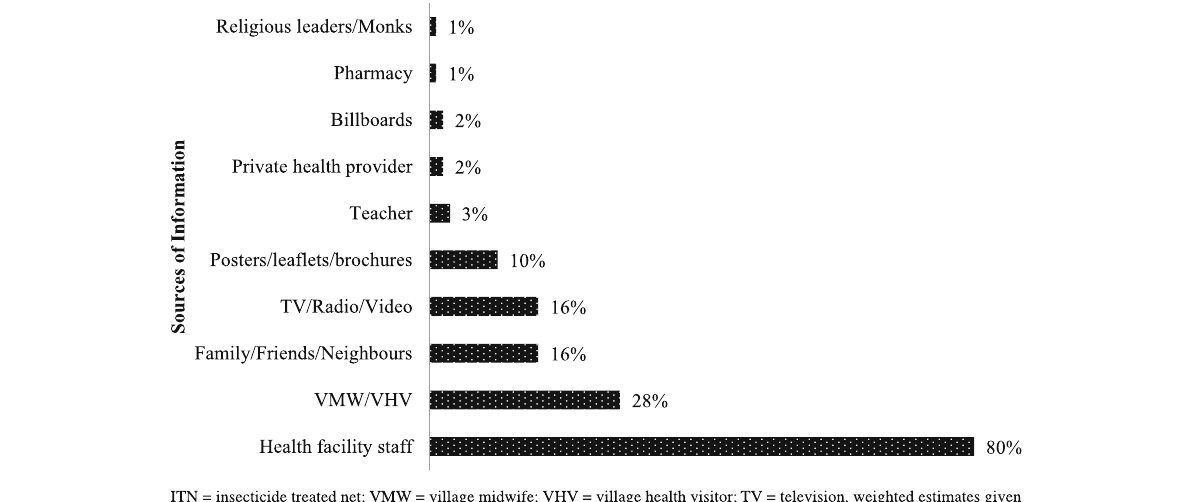
Fig. 5 Source of information for knowledge about malaria among the general population in the endemic regions of Myanmar in